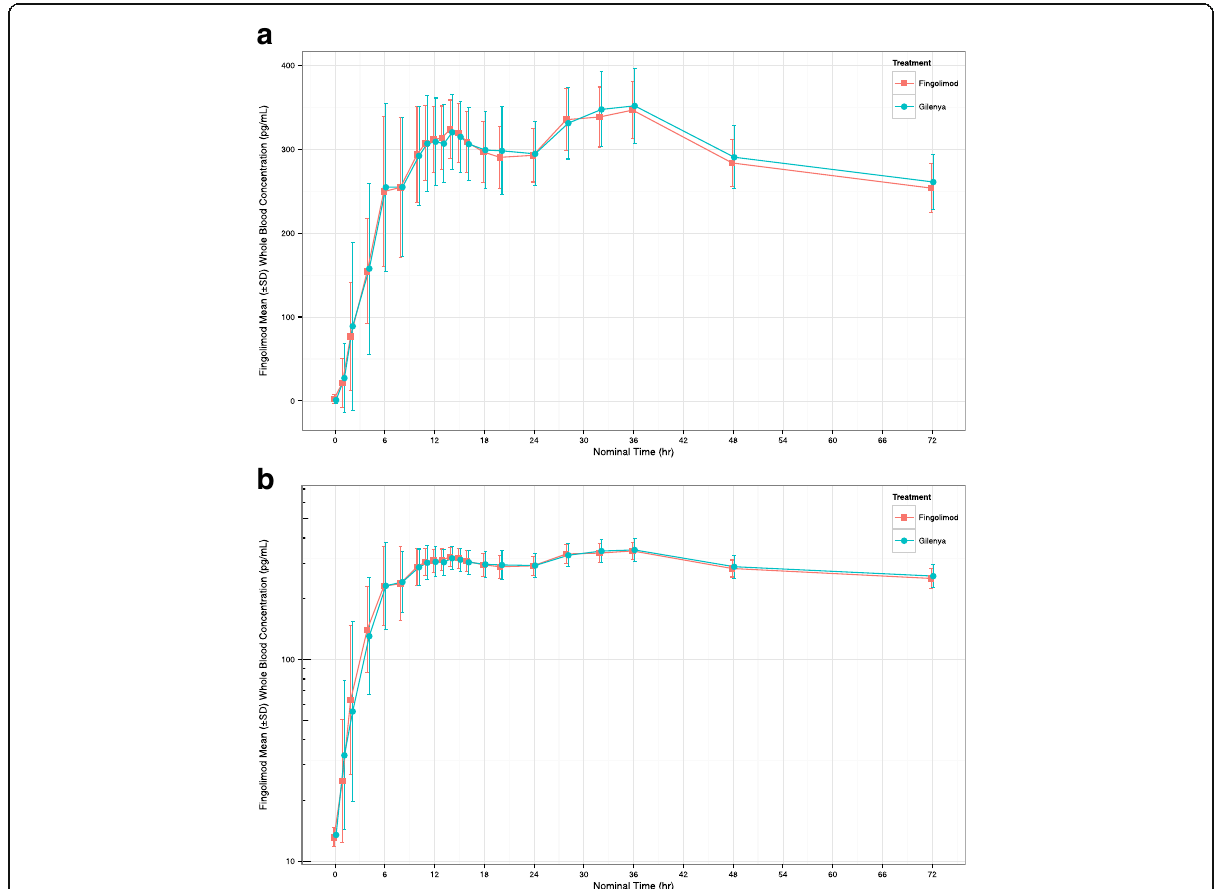
Fig. 1 Concentration – Time Profiles for Test and Reference Fingolimod on Linear ( a ) and Log ( b ) Scales